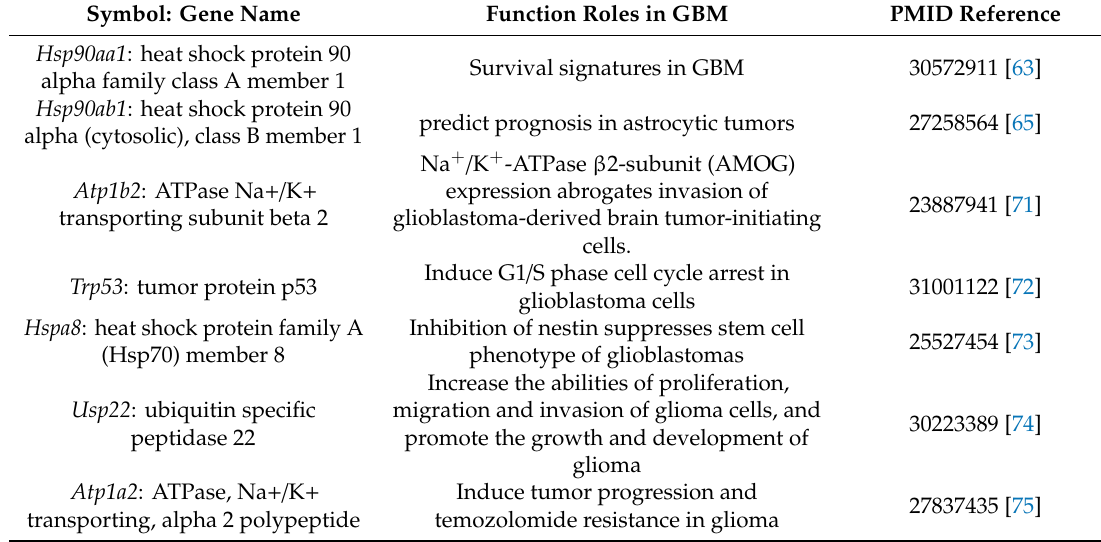
Table 7. The biological functions, corresponding PubMed IDs and literature references for enriched genes by GO enrichment analyses between NPC and